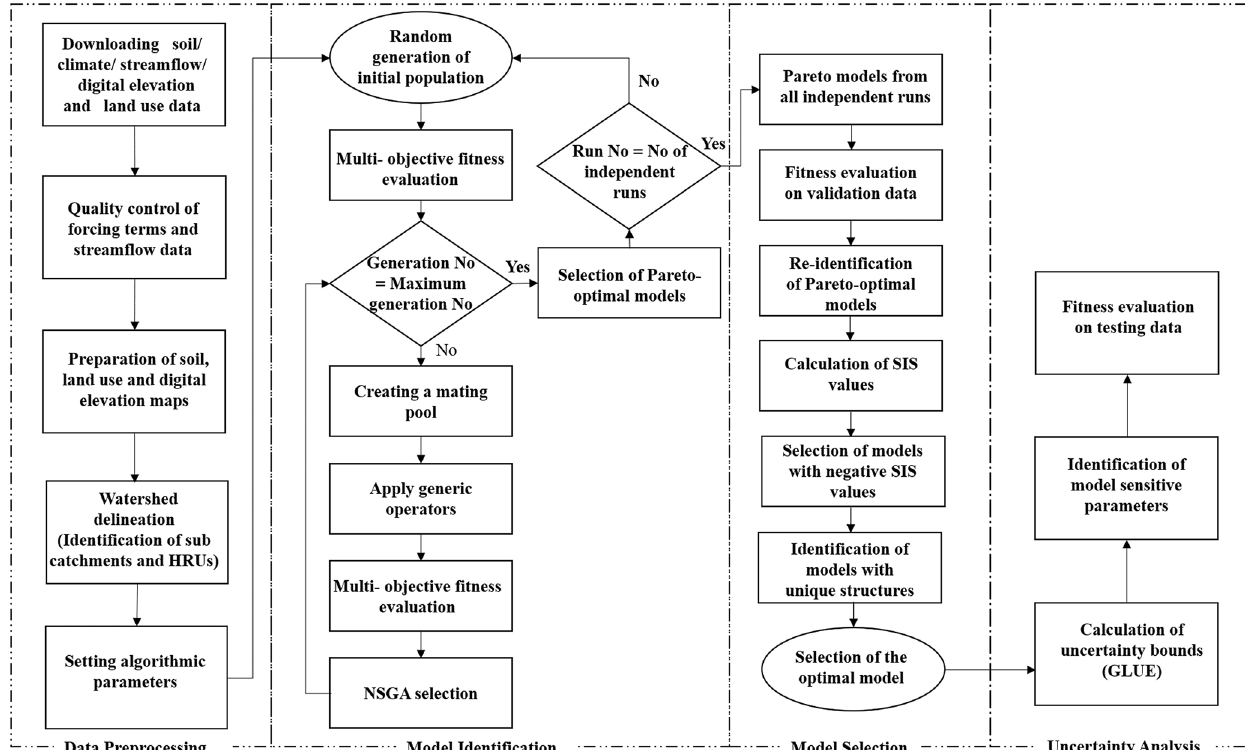
Figure 1. Workflow diagram of